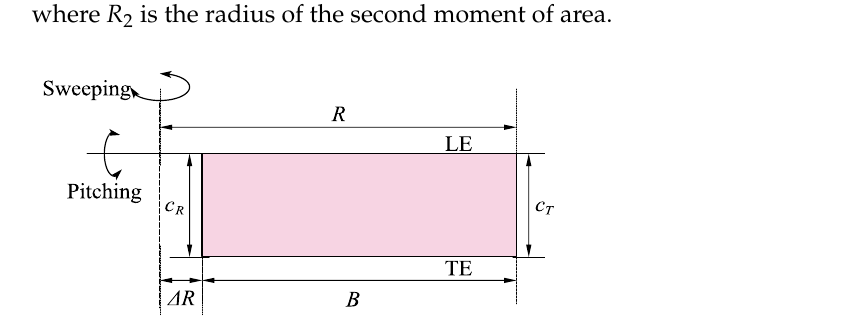
Figure 1. Schematic diagram of the wing planform and geometric parameters. LE means leading edge, and TE means trailing edge.